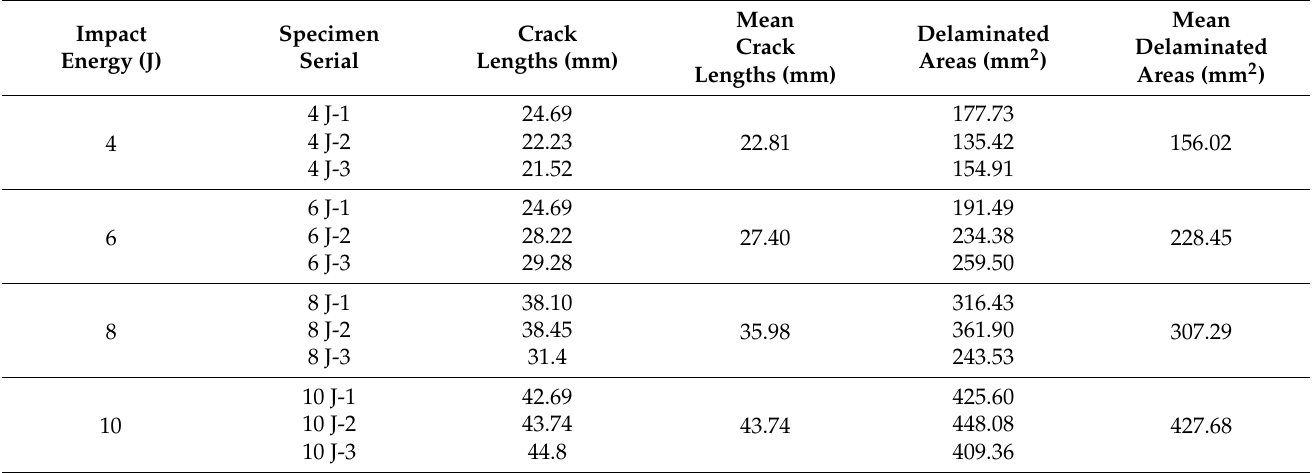
Table 4. Damage size of